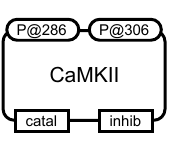
Figure 2.17: An example representation of calcium/calmodulin kinase II